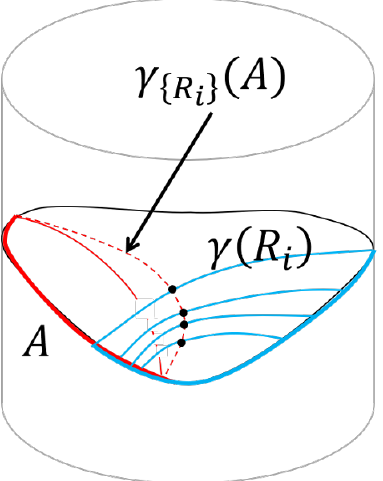
Figure 18. Illustration of a constrained surface (red dashed curve) that is extremal except at intersections with multiple HRT surfaces (cid:13) ( R i ) (blue curves), with nested regions R i